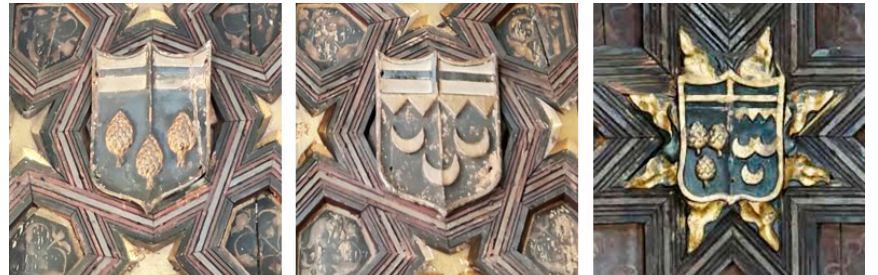
Figure 7. Details of the heraldic coat of arms (Pinelo and De la Torre families). Authors’ own pho- tographs, 2020.